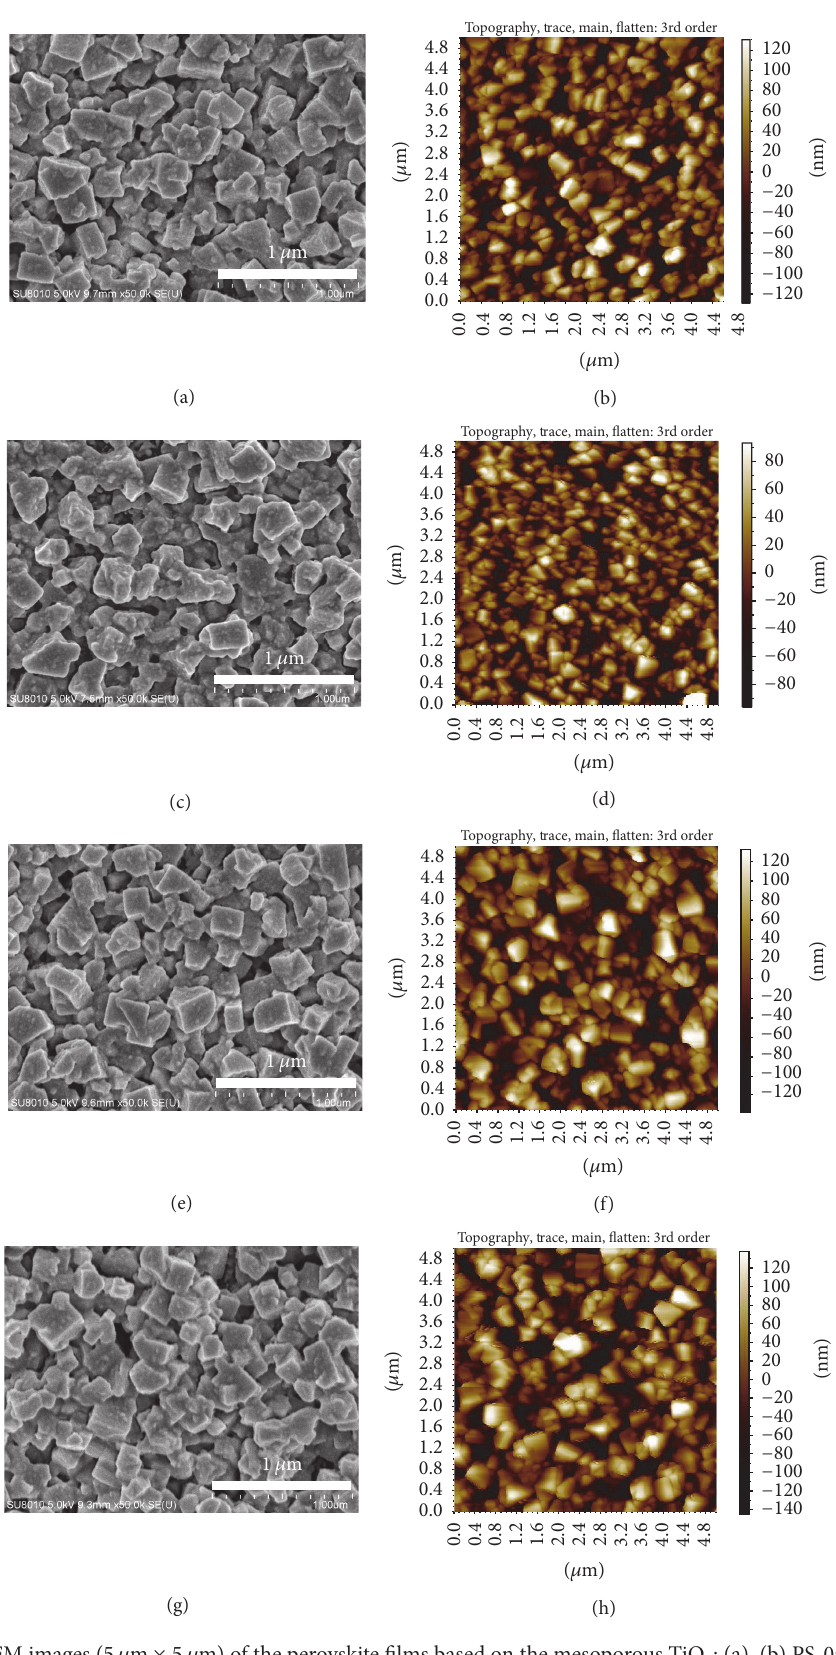
Figure 3: SEM and AFM images (5 𝜇 m × 5 𝜇 m) of the perovskite films based on the mesoporous TiO 2 : (a), (b) PS-0; (c), (d) PS-0.5; (e), (f) PS-1.0; and (g), (h)